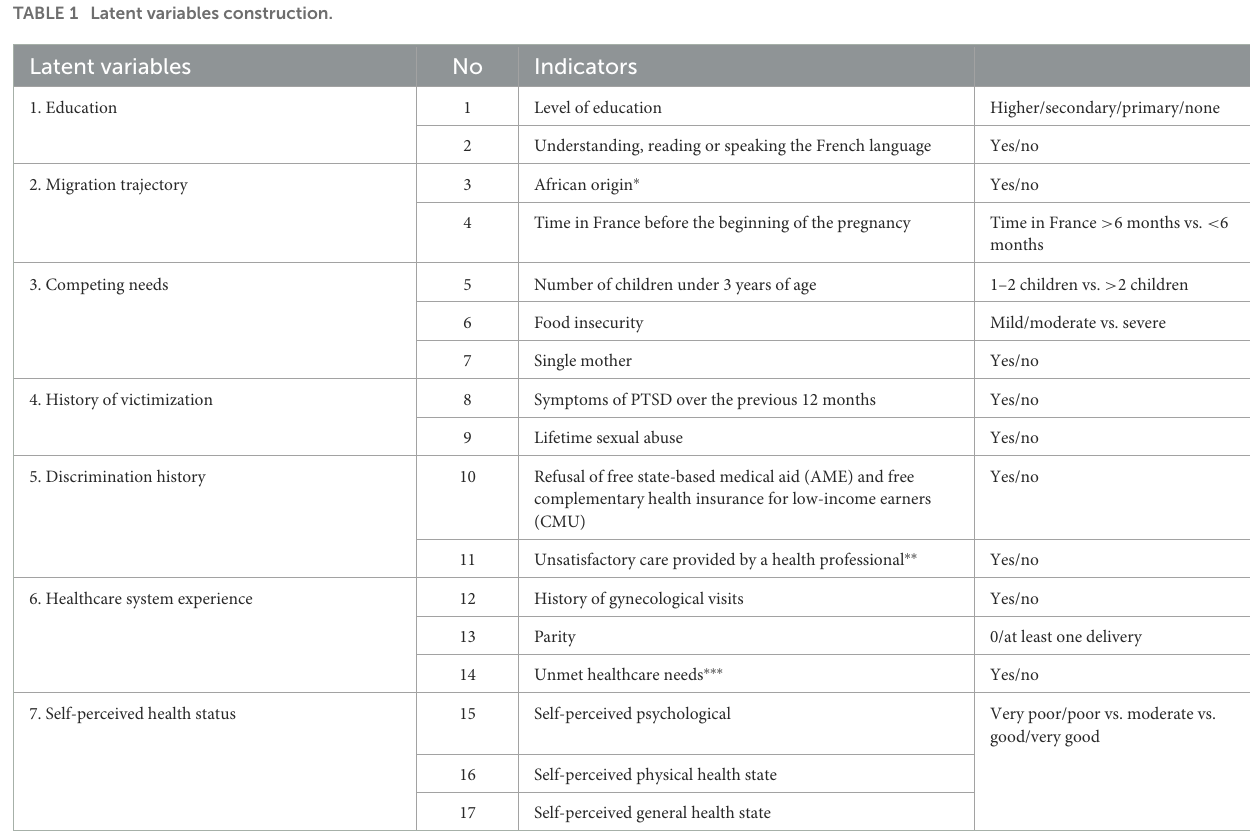
TABLE 1 Latent variables